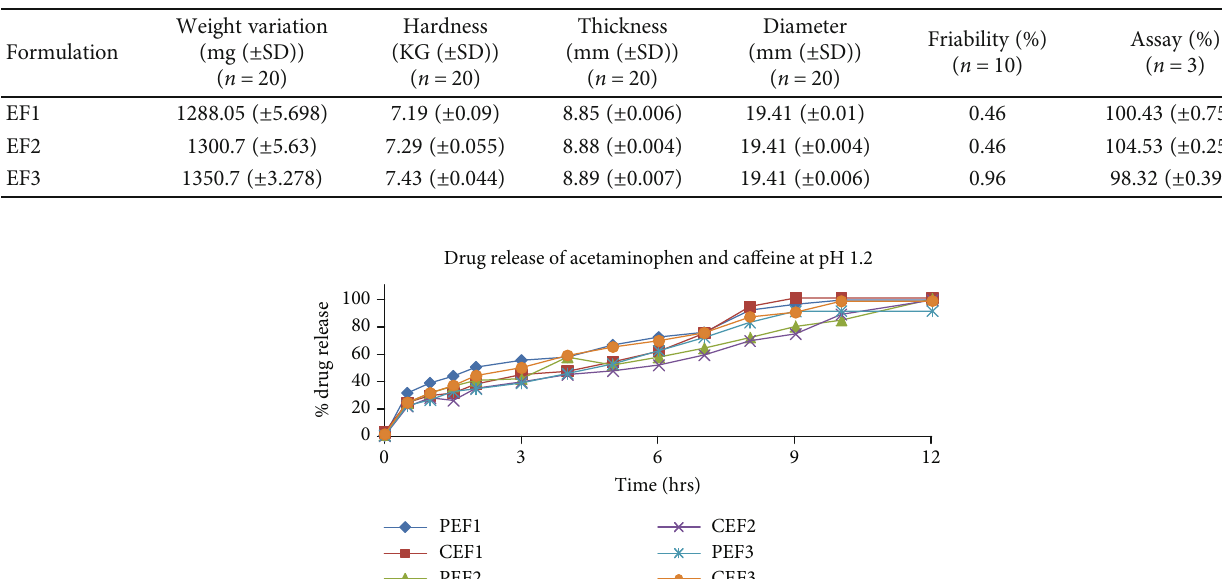
Table 3: Evaluation of postcompression parameters of formulation EF1-EF3.